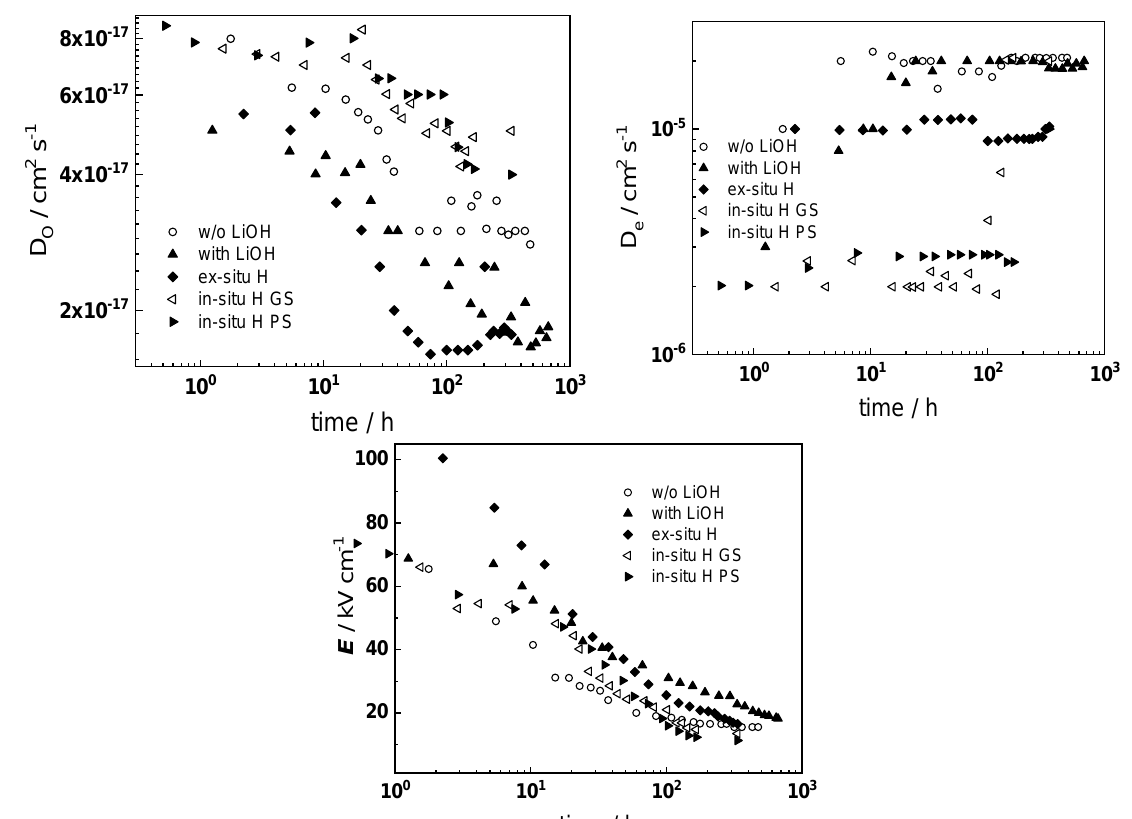
Figure 11. Defect transport parameters as a function of time and oxidation conditions.